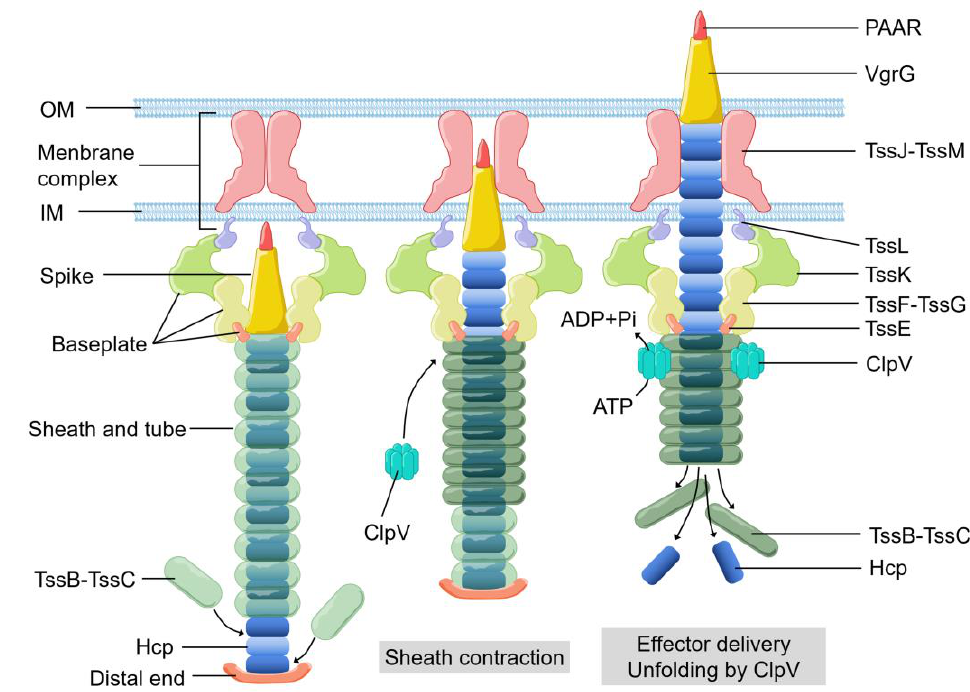
Figure 1. The basic components, structural assembly, and effector delivery of the T6SS apparatus. OM, outer membrane. IM, inner membrane.